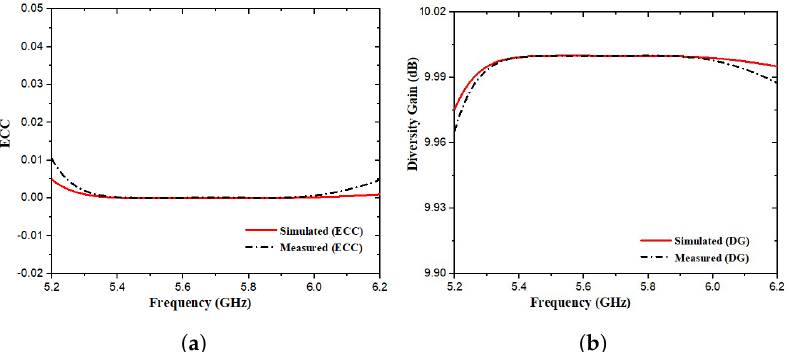
Figure 16. ( a ) Proposed simulated and measured ECC. ( b ) Proposed simulated and measured diversity